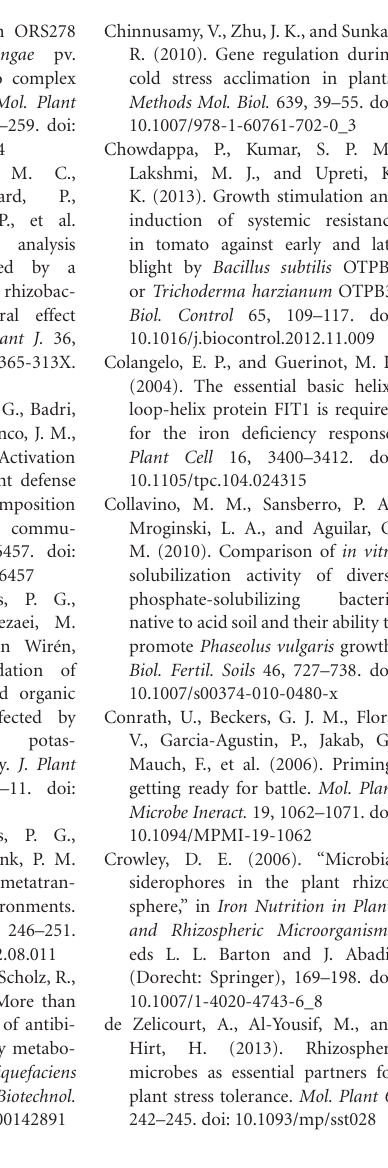
N 2 before storage at − 80 ◦ C. The photograph shows a typical plant grown in the absence of microbes. The red arrow indicates senescence at the cotyledons. Figure S2 | Carbon-nitrogen (C/N) ratios in whole plant tissues from Arabidopsis plants cultivated in the presence or absence of microbes. Figure S3 | ICP-OES analysis of total element concentration in sieved bulk soil from Arabidopsis plants grown in the presence or absence of soil microbes. (A) Macronutrients, (B) Micronutrients. Bars represent mean values in mg/kg soil dry weight (DW) ± SD from 3 independent replicates (100g soil pooled from 10 vessels/replicate). Figure S4 | Comparison of IRT1 and MYB72 expression in Arabidopsis plants grown in the presence or absence of soil microorganisms using either autoclaved or γ -irradiated soil as the growth substrate. qRT-PCR results from 3 biological replicates and SDs are